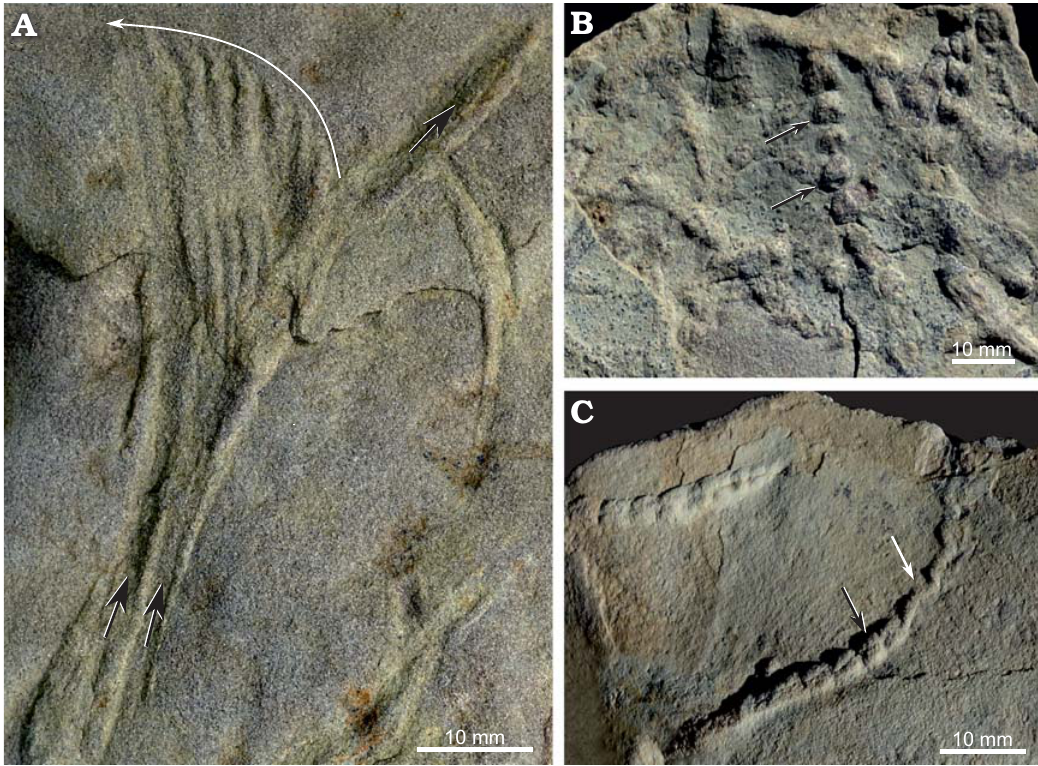
Fig. 4. Different ichnospecies of Gyrochorte encountered in the Mulichinco Formation, Lower Cretaceous, Puerto Curaco, Neuquén Province, Argentina (field photographs). A . Two parallel Gyrochorte comosa Heer, 1865 (black arrows, lower left), one continuing as such (black arrow, upper right), and one diverging from parallel course and becoming Gyrochorte variabilis Fürsich, Alberti, and Pandey, 2017 (shift of causative tube indicated by white arrow). B . Gyrochorte variabilis exhibiting circular, slightly bilobate pads (black arrows). C . Gyrochorte variabilis composed of elongate pads (black arrow) becoming oblique with slight zigzag pattern (white arrow). For details about G. variabilis see Fürsich et al. (2017). All specimens left in the field.